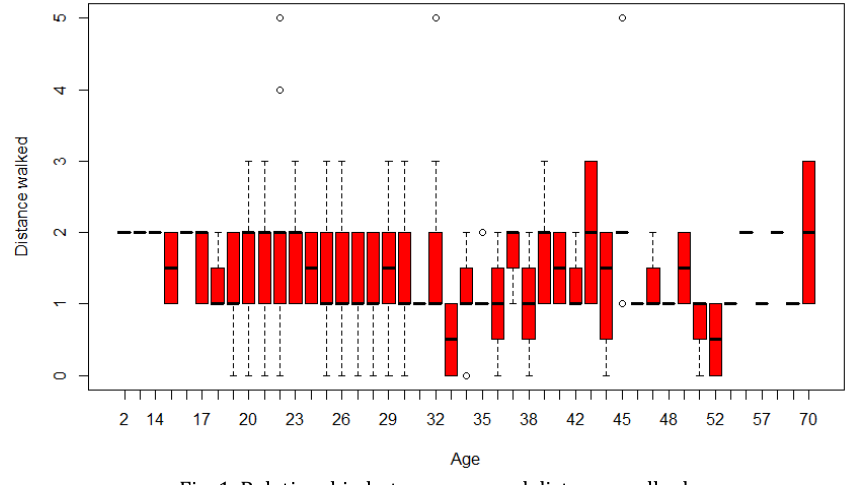
Fig. 1. Relationship between age and distance walked